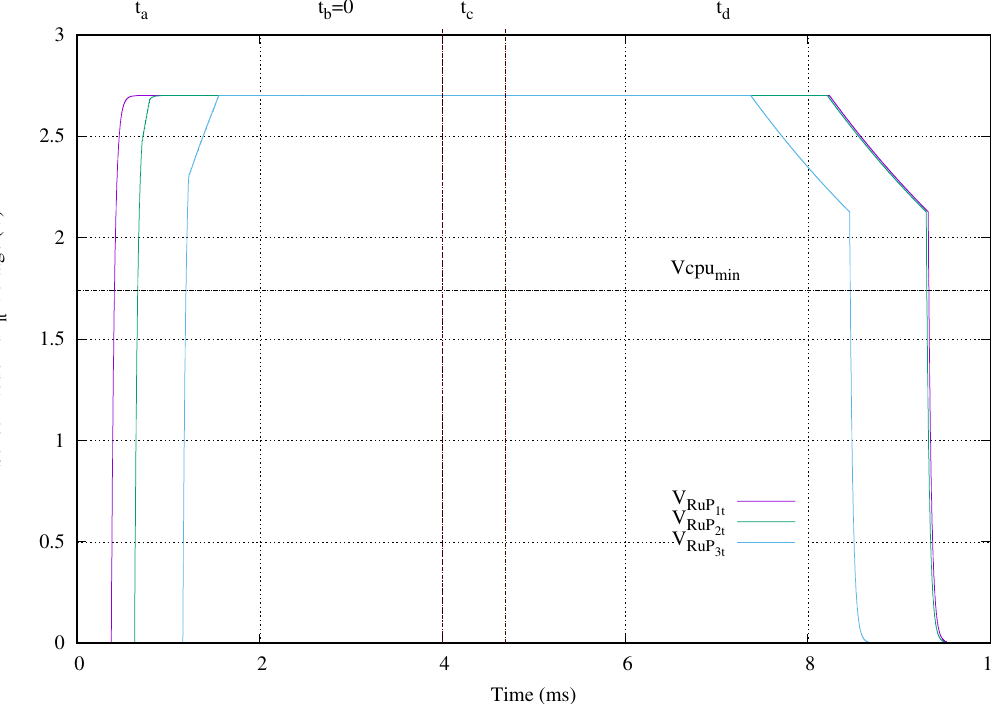
) obtained when a 4 ms tone of 134.2 kHz is applied and there it